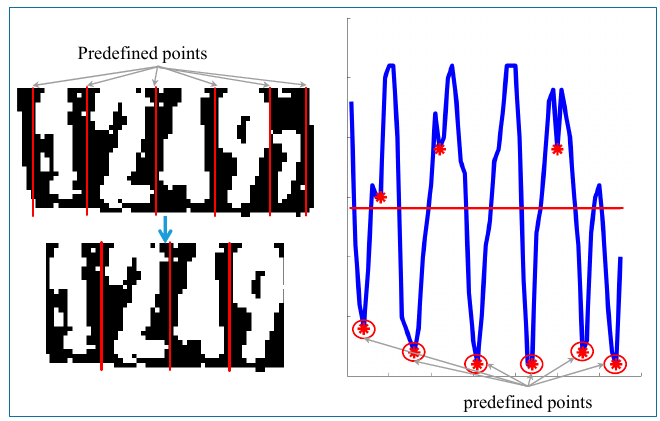
Figure 13. Digit area start point calculation. Sensors 2020 , 20 , x FOR PEER REVIEW